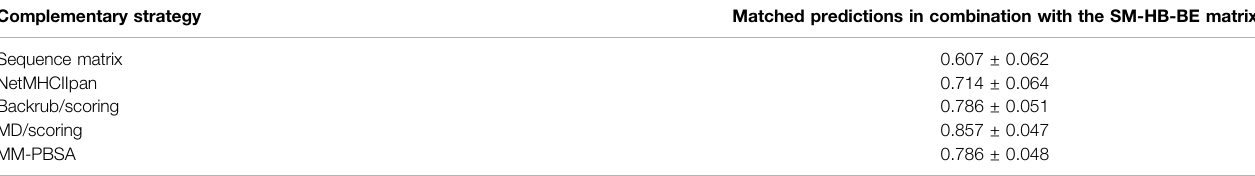
TABLE 5 | Match values and bootstrapping standard deviations for the prediction of the sign of the experimental activity differences by single point mutations of the peptide core amino acids. The results are for the combination of the additional methodologies with the SM-HB-BE matrix. The strategies are the sequence motif matrix, the machine learning tool NetMHCIIpan, the MD/scoring and backrub/scoring approaches, and the MM-PBSA calculations (see Methods). Complementary strategy Matched predictions in combination with the SM-HB-BE matrix Sequence